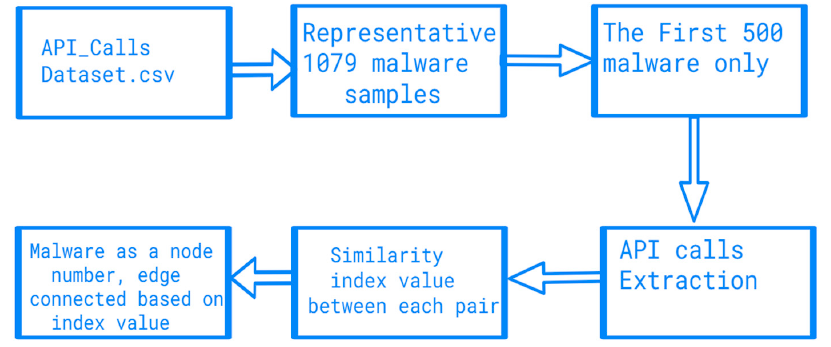
Figure 4. The workflow of API call sharing visualisation.